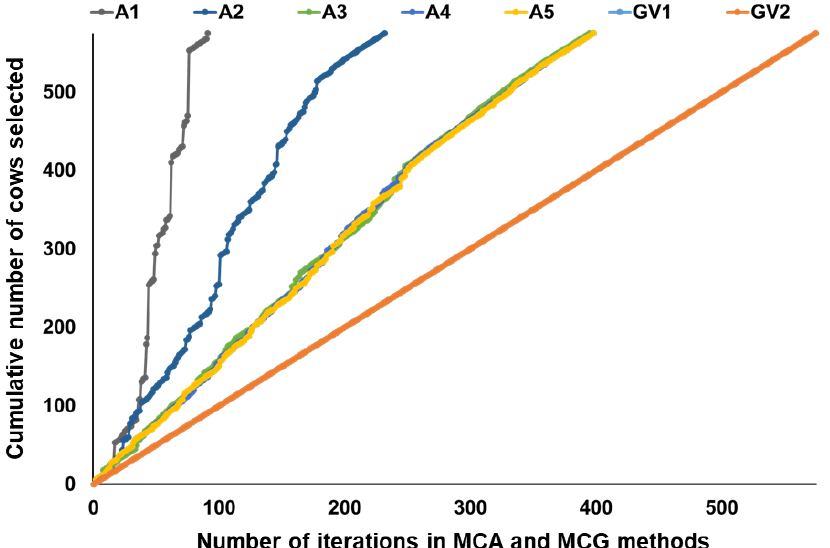
Figure 1. Changes in cumulative number of cows selected as candidates by MCA and MCG meth- ods.